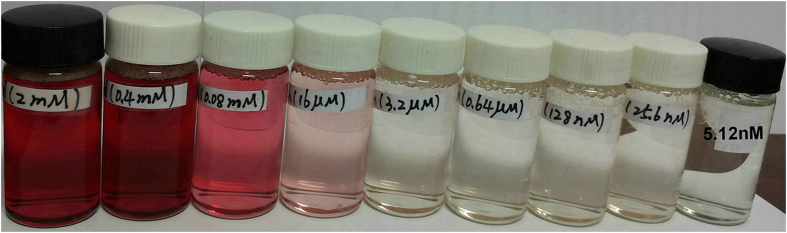
The optical photograph of the glucose samples.